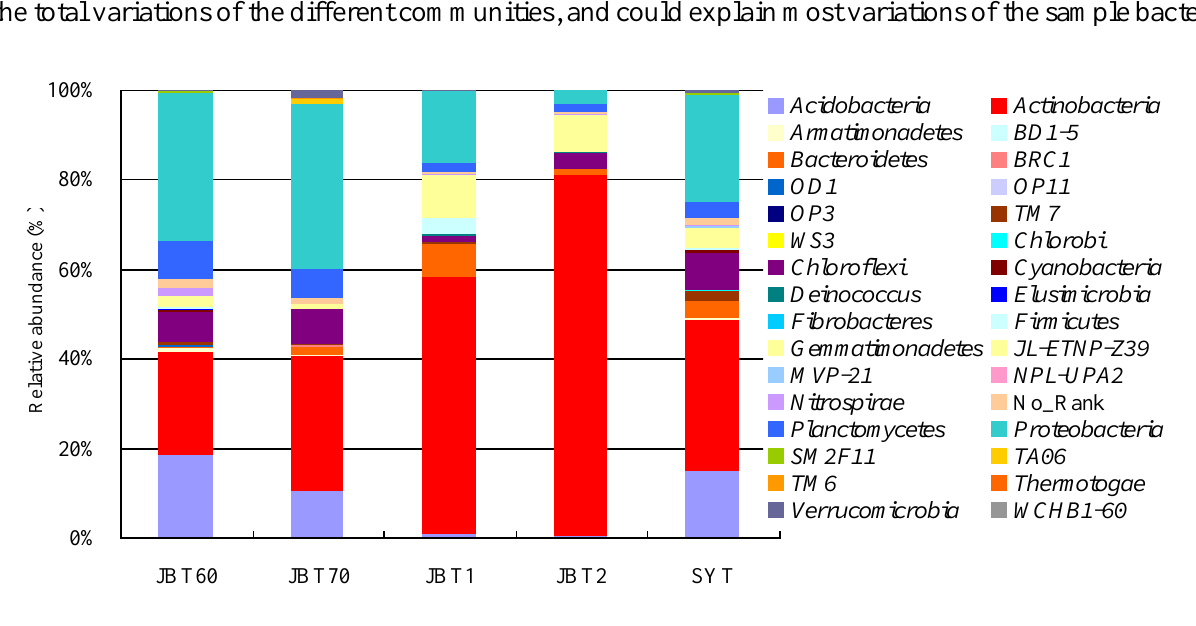
Figure 1. Relative abundance of predominant bacterial composition in the five samples. The abbreviation of samples is shown in Table 1.